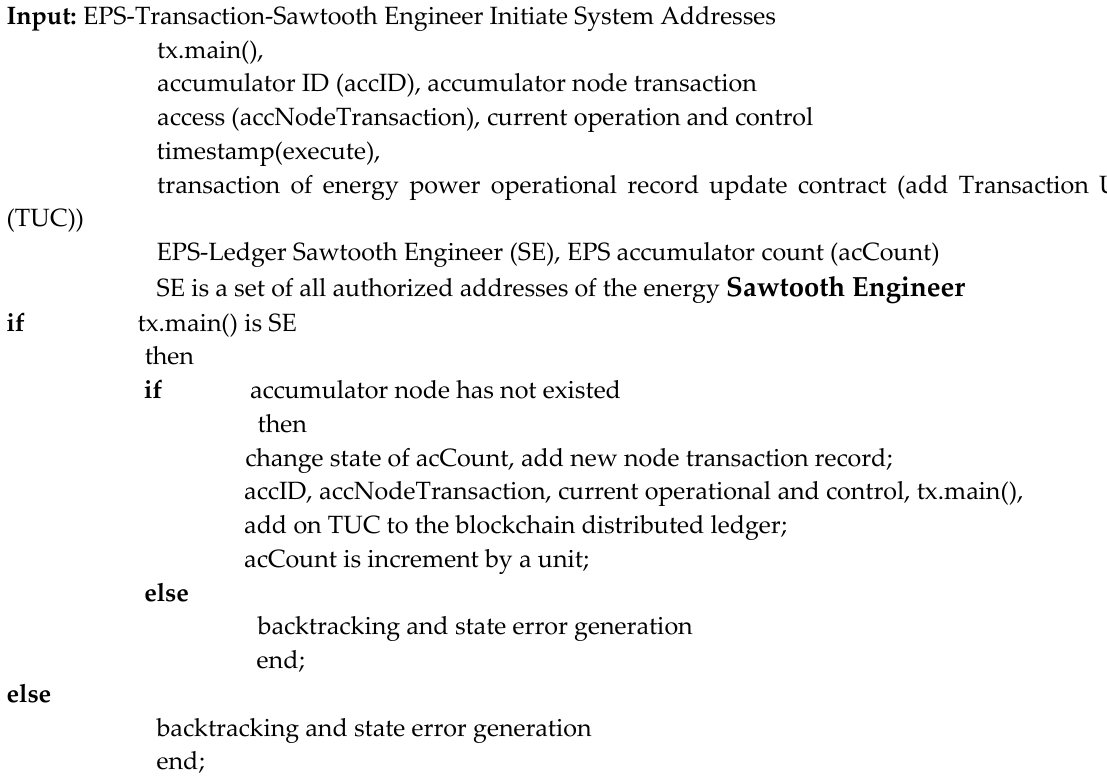
Algorithm 2 : addNode() Contract, The distributed power systems chain of operation and control accumulator contract (addNode()).